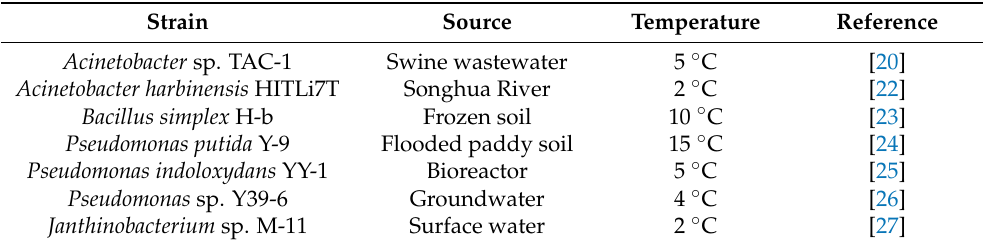
Table 1. List of cold-tolerant aerobic denitrifying bacteria reported in different environments. Strain Source Temperature Reference Acinetobacter sp. TAC-1 Swine wastewater Bacillus simplex H-b Frozen soil Pseudomonas putida